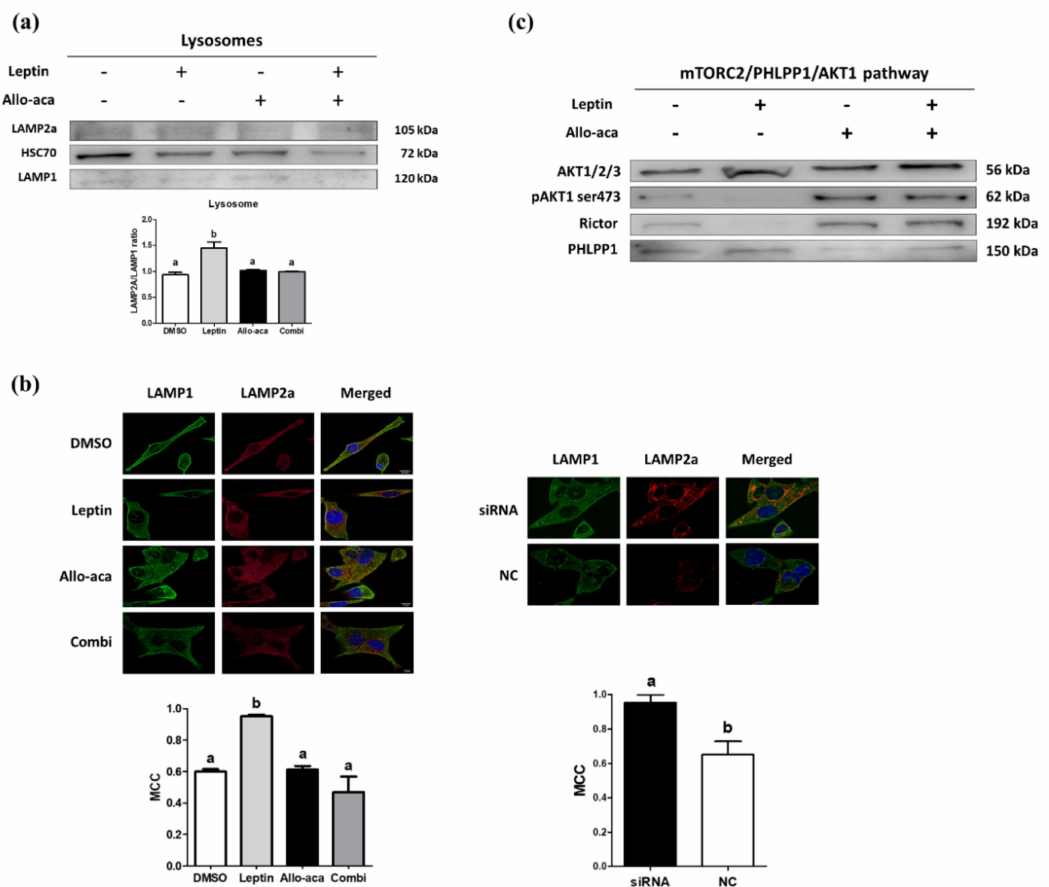
Figure 4. Leptin induced a higher LAMP2a / LAMP1 ratio in lysosomal membranes. ( a ) Western blot analysis of lysosomes isolated from CHMp cells targeting CMA-associated lysosomal proteins. The results showed that the LAMP2a / LAMP1 ratio was increased with leptin treatment and Allo-aca acted as a leptin receptor (OBR) antagonist. Then, the samples were subjected to SDS-PAGE. ( b ) Leptin and Allo-aca-treated CHMp cells and CTSA siRNA were visualized with confocal microscopy with immunofluorescence technique. The colocalization ratio was measured by Fiji software developed by Schindelin and colleagues [31] and analyzed on the basis of Mander’s colocalization coe ffi cient (MCC). The results were in concordance with the lysosome immunoblot experiments. ( c ) Western blot analysis of the lysosomal mTORC2 / PH domain and leucine rich repeat protein phosphatase 1 ( PHLPP1 ) / AKT1 pathway in lysosomes isolated from CHMp cells. pAKT1(ser473) and rictor were inhibited with leptin treatment, but PHLPP1 was stimulated. All graphs are visualized as mean ± SEM with at least three replicates. The column bars with di ff erent alphabetical letters indicate significant di ff erence among groups ( p < 0.05). Combi: combination of leptin and Allo-aca; NC: negative control